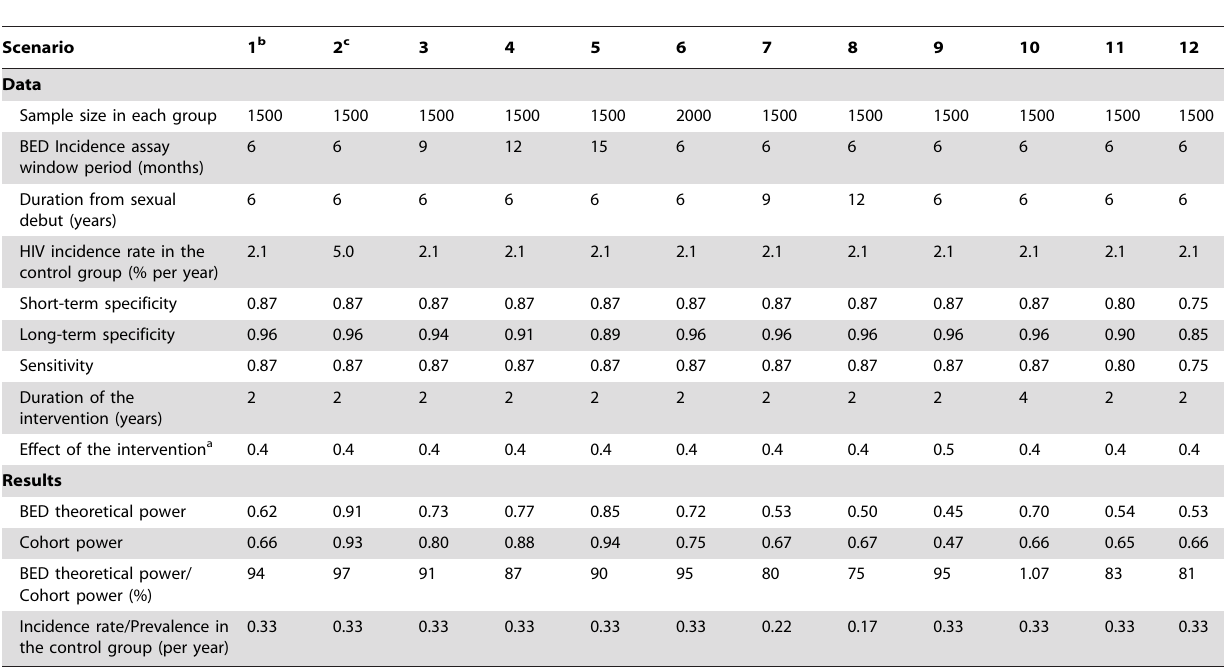
Table 1. BED theoretical power needed to obtain a statistically significant HIV incidence rate ratio among young people when using BED incidence testing; results were obtained by simulations.